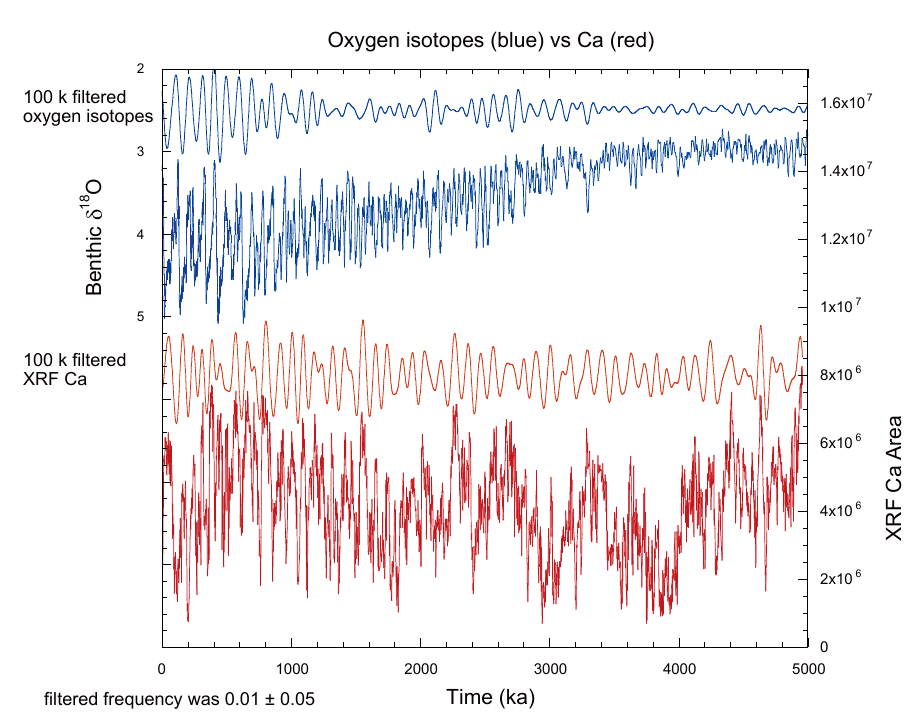
Figure 7. Oxygen isotope stack of Lisiecki and Raymo (2005) plotted against Ca peak area from XRF scanning (a measure of CaCO 3 content) at Site U1338. Also plotted are 100-kyr bandpass filter records (Gaussian filter with frequency of 0.01 kyr -1 ±0.005). Initial analysis suggests that the 100-kyr period in the XRF Ca area record is a dissolution cycle because it is not present in the shallower sediments recovered by ODP Leg 138. There is a strong ‘eccentricity’ cyclicity in the deep Pacific even when polar ice, represented by oxygen isotopes, was waxing and waning with a 41-kyr period prior to 1